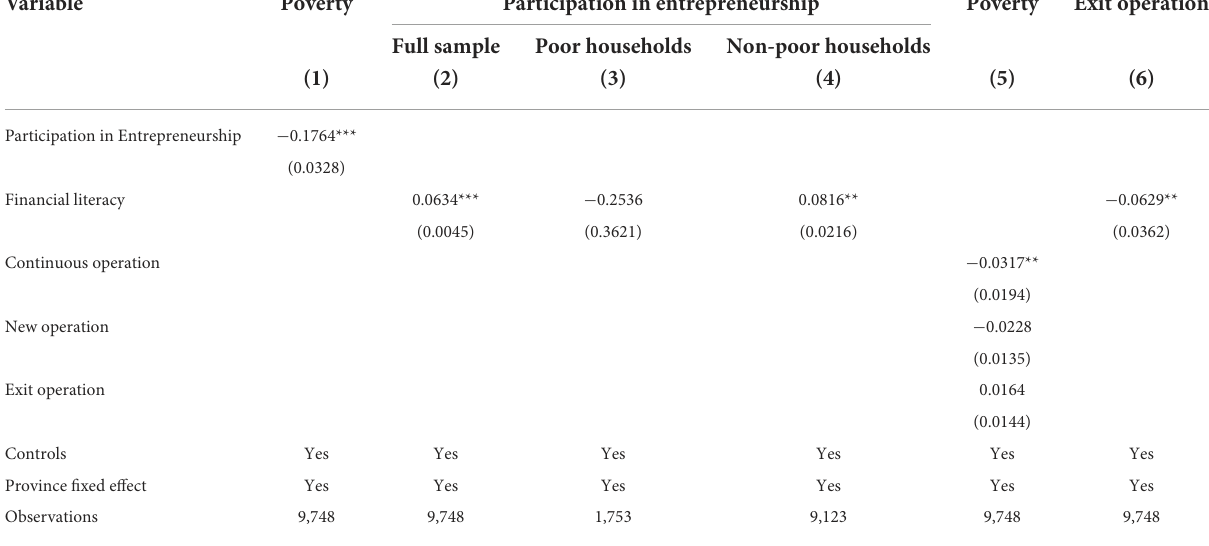
TABLE 8 Test on the impact mechanism of financial literacy on relative poverty (2SLS estimation).